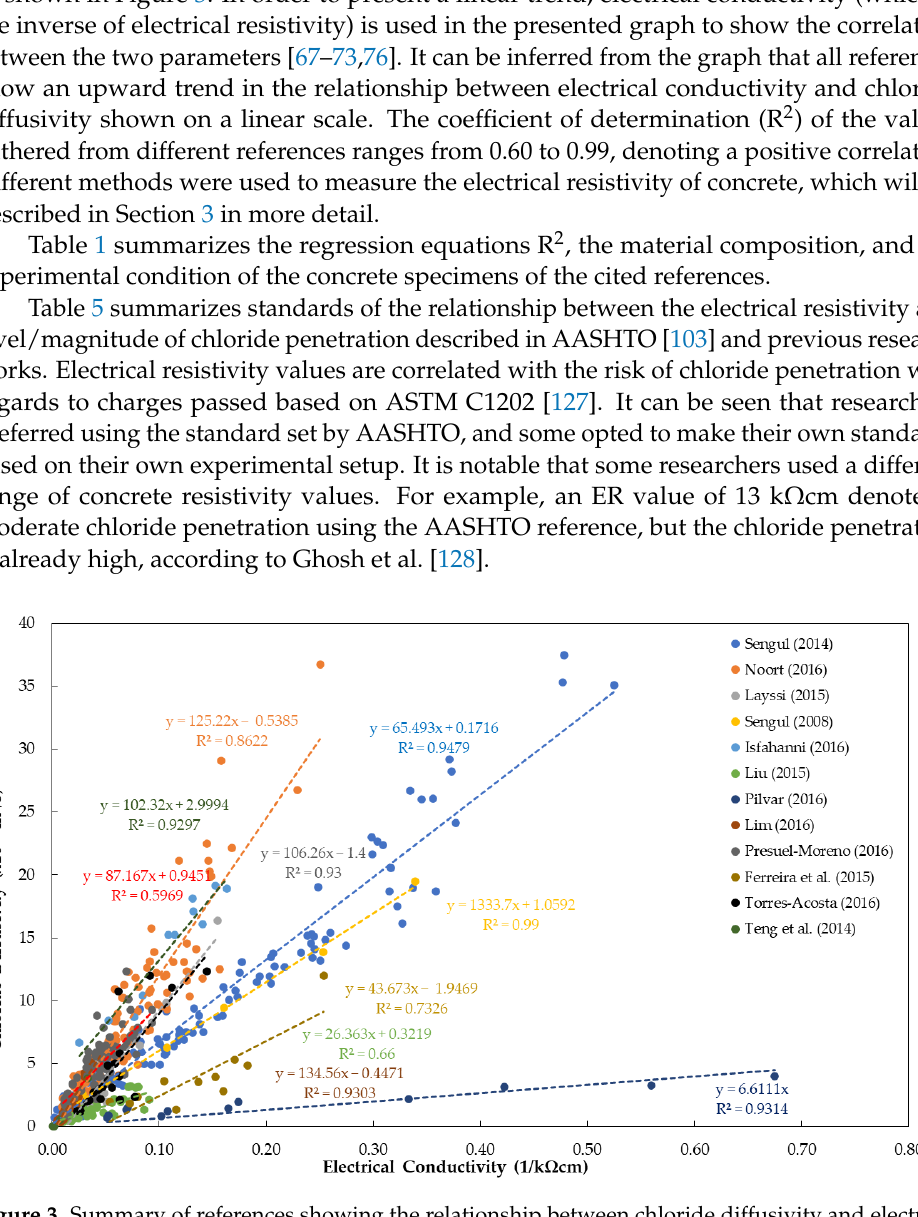
Figure 3. Summary of references showing the relationship between chloride diffusivity and electrical conductivity(1/ER).